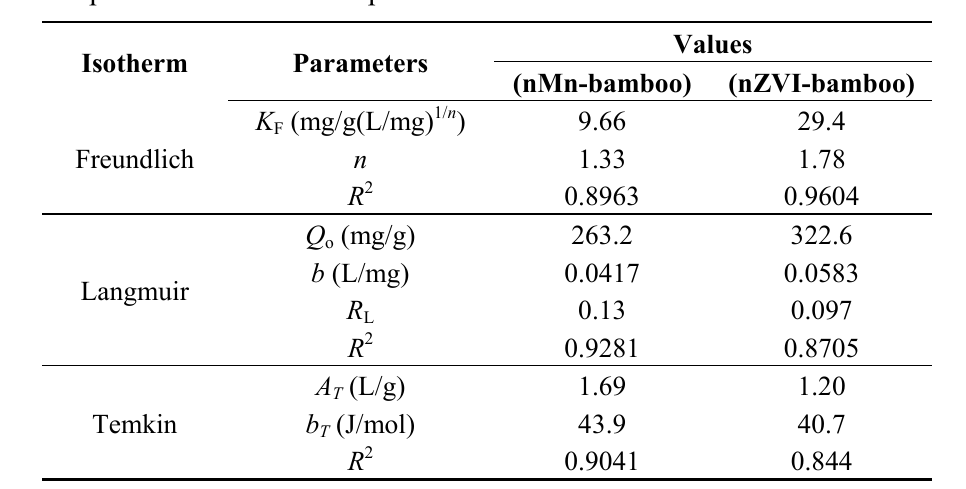
Table 3. Isotherm parameters for the adsorption of MB onto nMn-bamboo and nZVI-bamboo